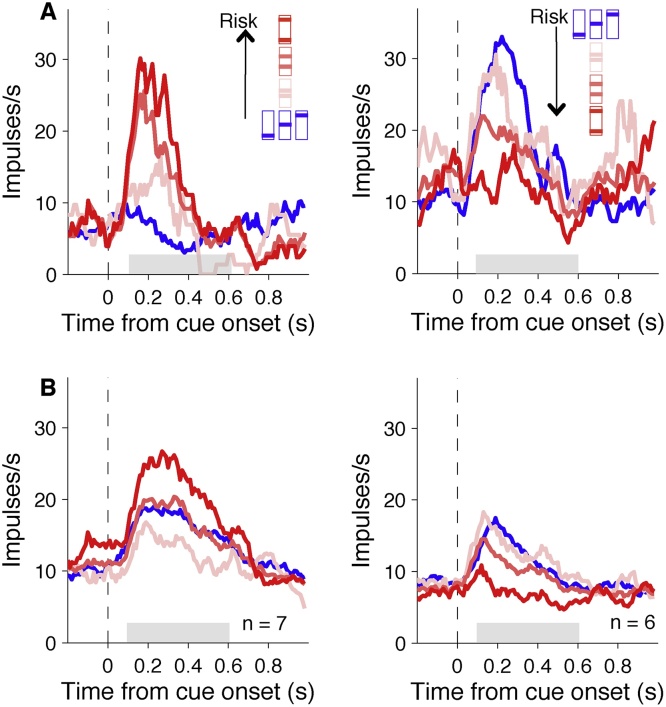
Orbitofrontal neurons code reward risk. (A) Smoothed histograms showing examples of individual neurons coding risk following cue onset with positive slope (left) or negative slope (right). The shaded area shows the time window used for analysis. (B) Smoothed histograms showing population responses from all neurons with statistically significant correlation coefficients for risk during the shaded period. Colour scheme the same as Fig. 2.